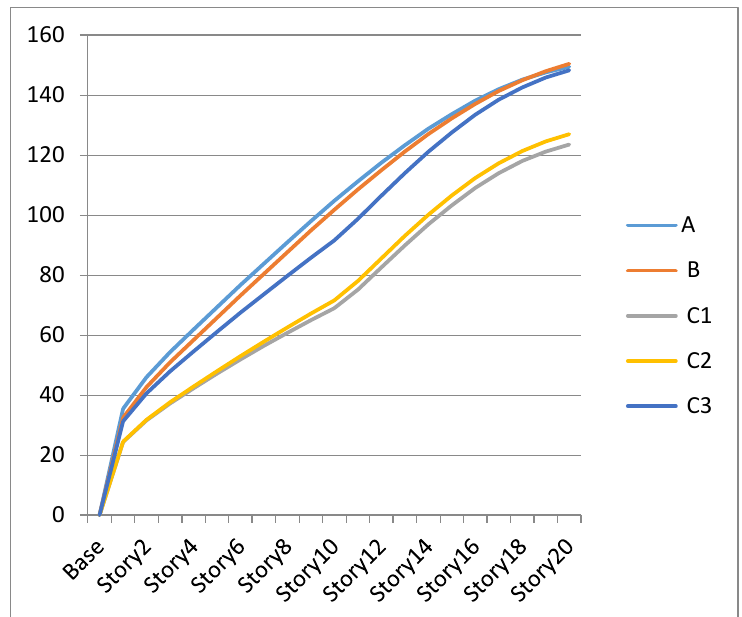
Fig. 4. Story displacement